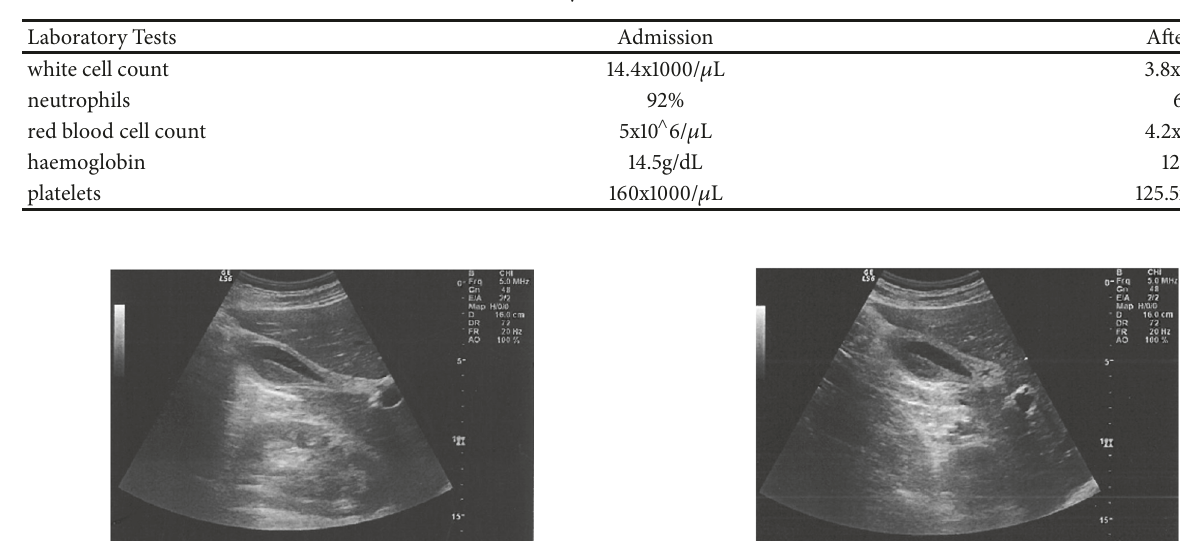
Table 1: Laboratory data at admission and after 36 hrs.